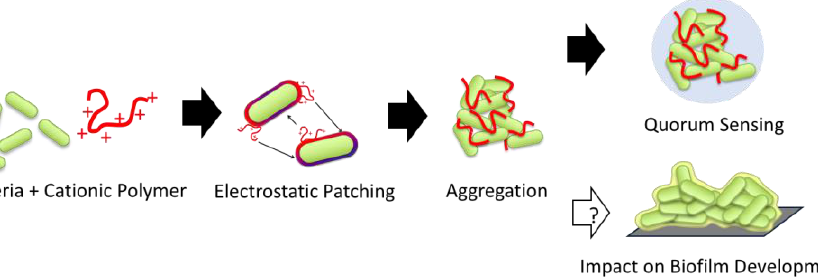
Figure 1. Cationic polymers can control bacteria aggregation, which has been previously linked to quorum sensing, an important part of biofilm formation. However, no studies have linked polymer modulated bacteria activity with biofilm development.